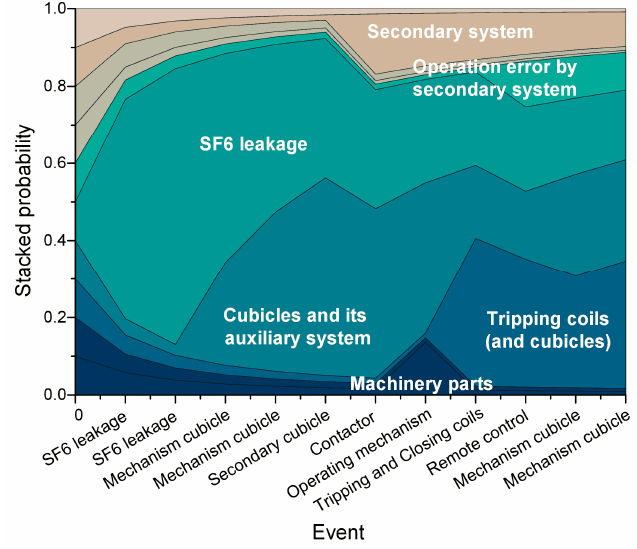
Figure 13. Time-varying dynamics of the failure patterns for an individual HVCB.